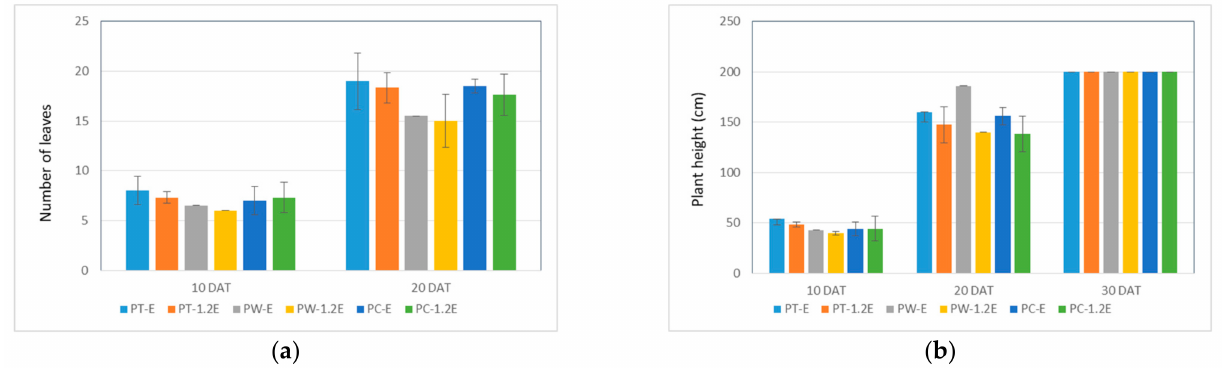
Figure 11. Plant growth performances among the treatments: ( a ) number of leaves, ( b ) plant height.